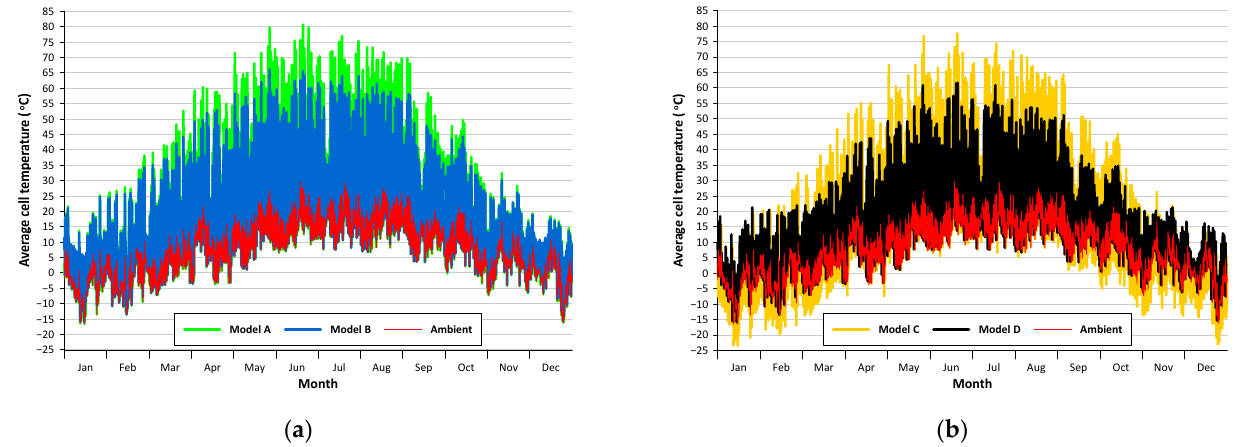
Figure 5. Changes of average cell temperature for (cid:2010) equal 0.005: ( a ) Models A and B; ( b ) Models C and D. Figure 6. Average cell temperature changes in models on 19–21 June for (cid:2010) equal 0.005 K − 1 .